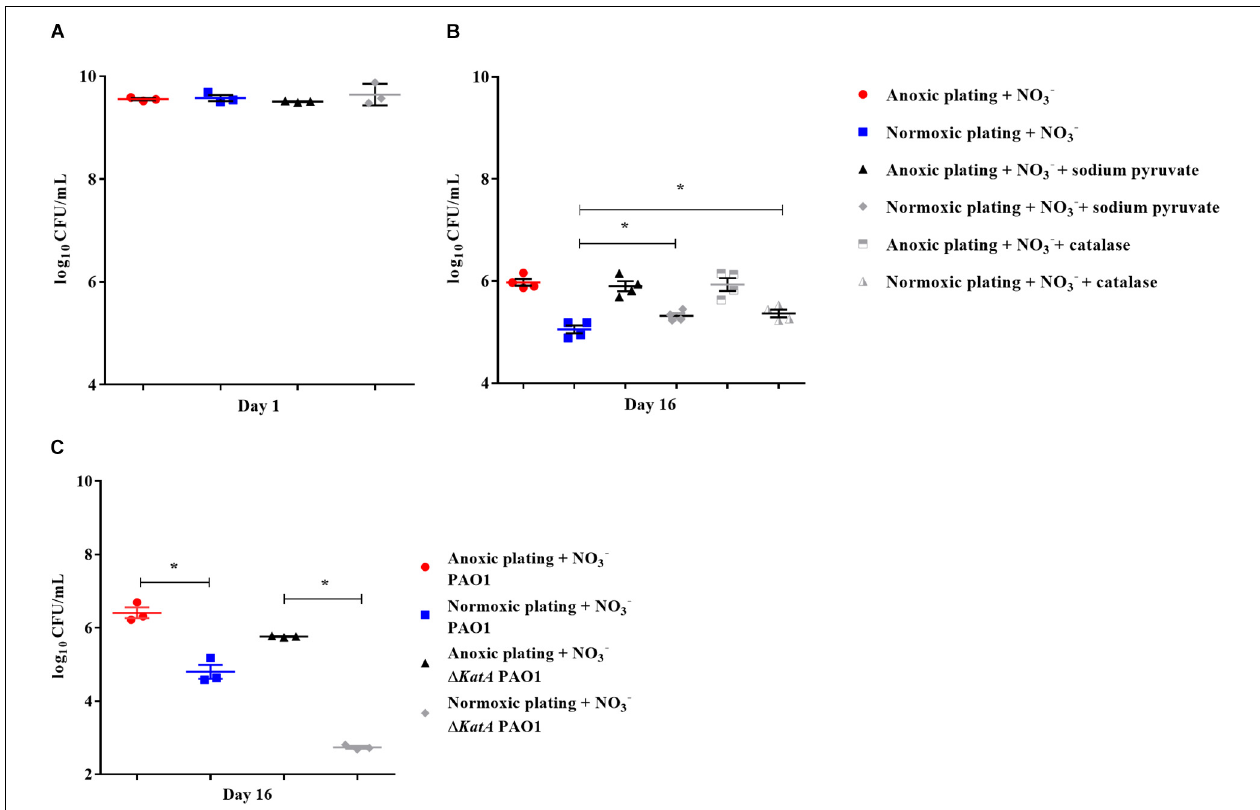
FIGURE 7 | Reactive oxygen species generates a difficult-to-culture subpopulation of Pseudomonas aeruginosa (PAO1). Normoxic and anoxic colony forming units per milliliter (CFU/mL) were determined for 24-hour-old batch cultures (A) and 16-day-old anoxically conditioned batch cultures (B) of PAO1. Normoxic CFU/mL was determined ± 0.3% sodium pyruvate (A,B) , while addition of catalase was only tested for 16-day-old batch cultures. Symbols with error bars indicate the mean ± SEM ( n = 4). + NO 3 - refers to the addition of 10 mM KNO 3 to LB agar plates. There was a significant difference between normoxic plating ± 0.3% sodium pyruvate ( p = 0.04, One-way ANOVA test) and normoxic plating ± catalase ( p = 0.03, One-way ANOVA test). Normoxic and anoxic determination of CFU/mL were determined for 16-day-old anoxically conditioned batch cultures of PAO1 and (cid:49) katA PAO1 (C) . Symbols with error bars indicate the mean ± SEM ( n = 3). Significant difference between anoxic and normoxic plating with both PAO1 and (cid:49) katA PAO1 ( p = 0.0014 and p < 0.0001, respectively, unpaired T -test). ∗ p <